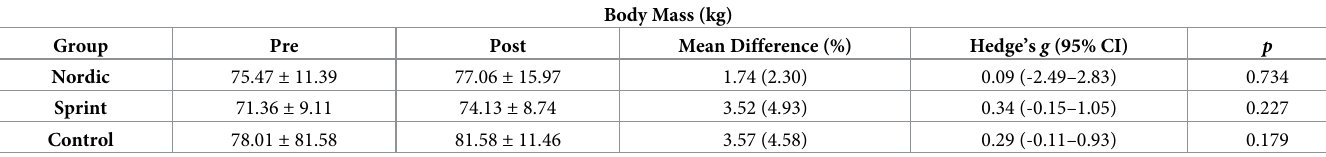
Table 4. Pairwise comparisons of body mass for all training